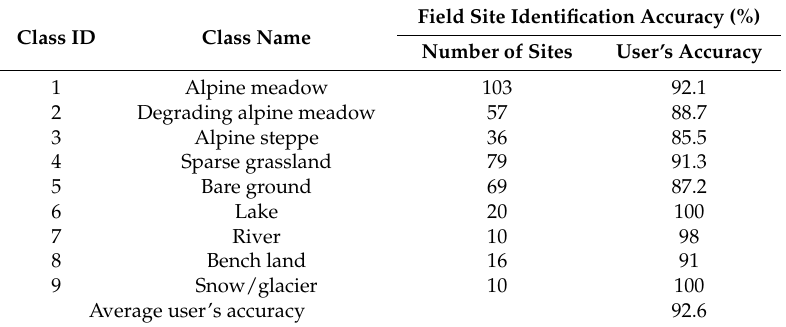
Table 5. Statistical coefficients and accuracy assessments for the model.